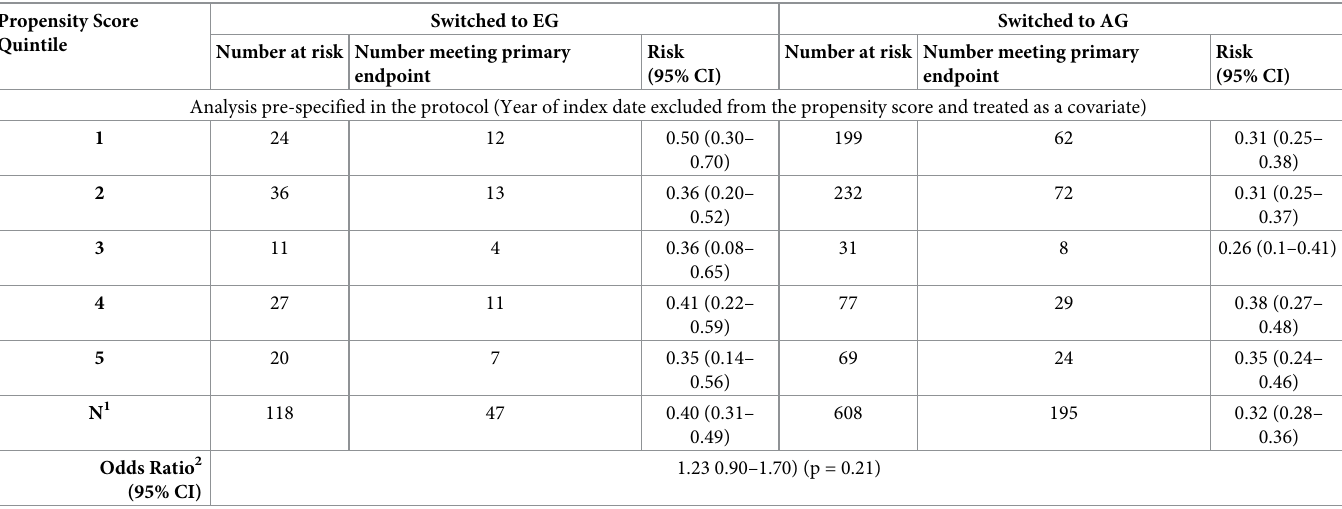
Table 4. Primary study endpoint adjusted odds ratio.